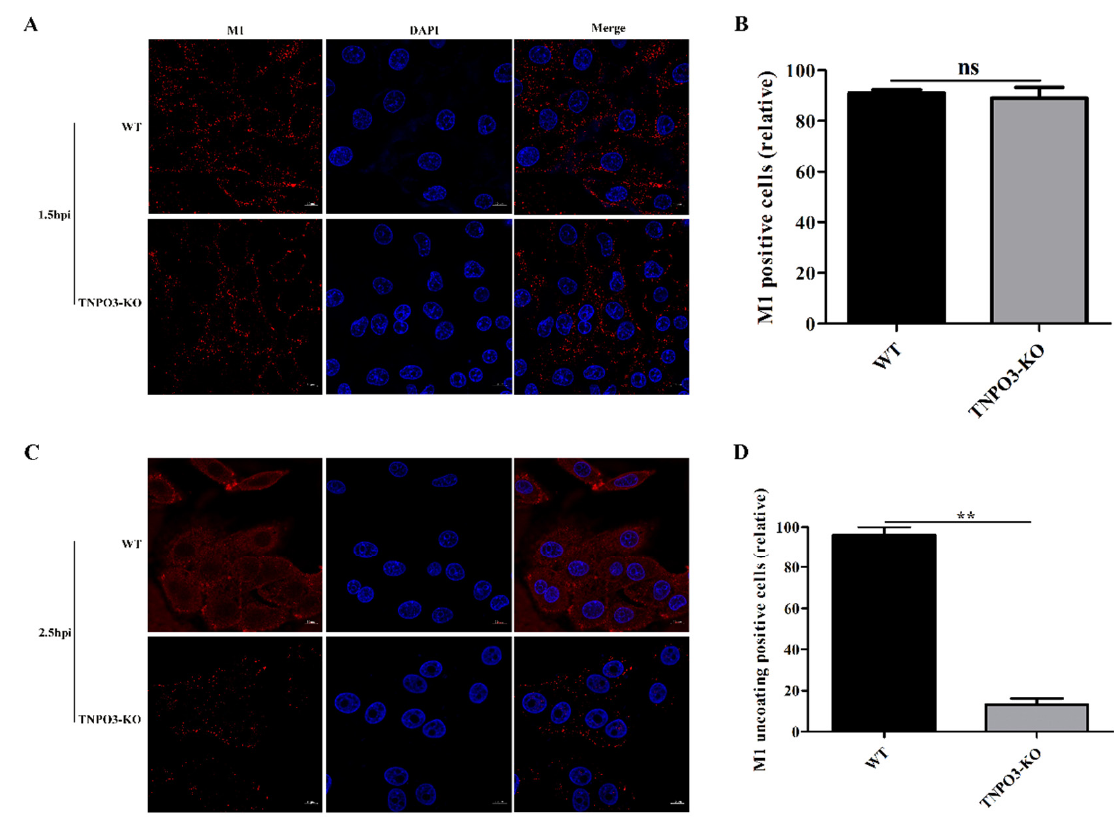
Figure 4. Knockout of TNPO3 inhibits uncoating during IAV entry. WT cells and TNPO3-KO cells were infected with HuB/H1N1 (MOI = 10) and fixed at ( A , B ) 1.5 h and ( C , D ) 2.5 h post infection. ( A , C ) Confocal microscopy analysis of viral-encoded M1 in WT and TNPO3-KO cells after IAV infection. Scale bar = 20 µm. ( B , D ) analyzing the relative ( B ) M1 positive or ( D ) M1 uncoating positive cells of two independent experiments as shown in ( A ) and ( C ). **, p < 0.01; hpi, hour post infection; WT, wild-type; KO, knockout.